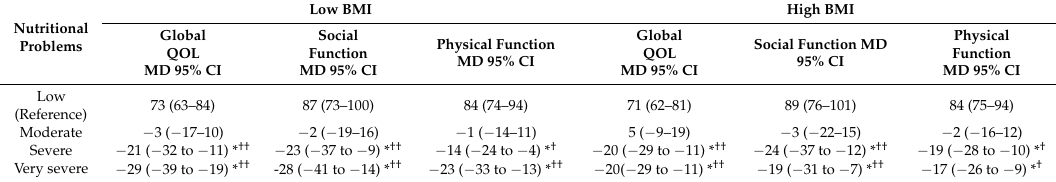
Table 2. Health related quality of life scores of patients who underwent surgery for oesophageal cancer comparing the reference exposure group to the other three exposure groups stratified by preoperative